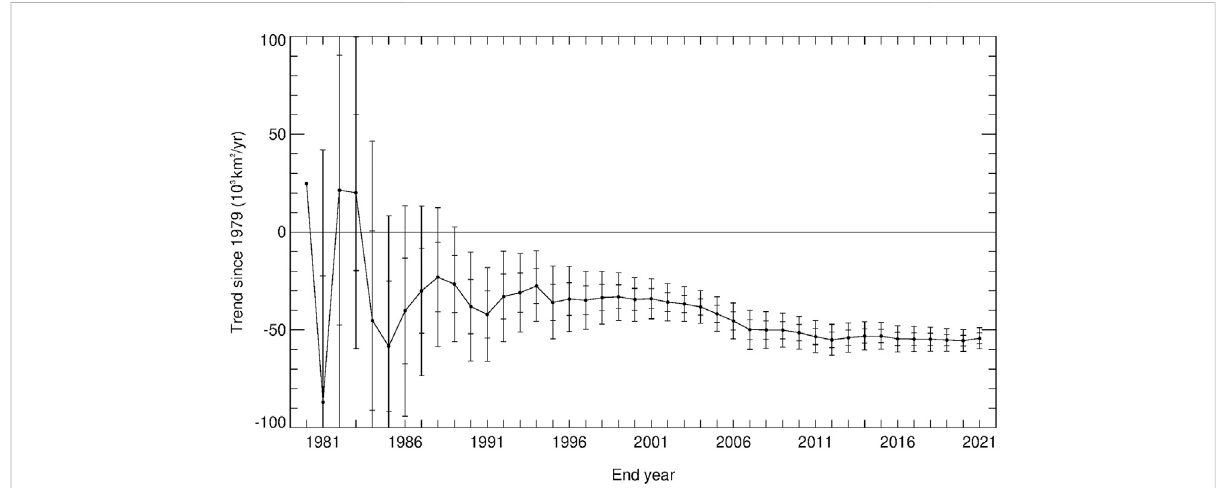
FIGURE 3 Linear-least-square slopes of the trend line in Arctic yearly average sea ice extents, from the 1979 – 1980 slope with only 2 years of data to the 1979 – 2021slopewith43 yearsofdata.Thebarscenteredoneachtrendvalueafterthe fi rsthaveticksmarkingoneandtwostandarddeviationsfrom the